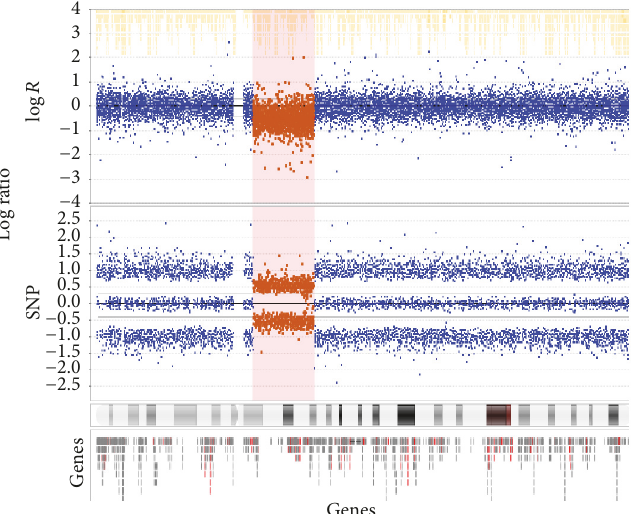
Figure 2: Affymetrix 750 K SNP Array, chromosome 4.